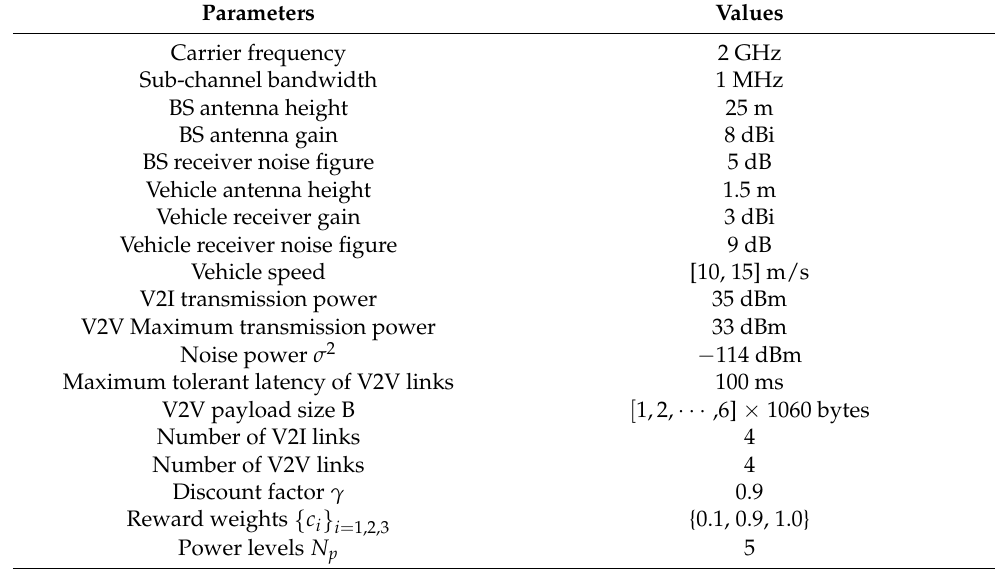
Table 2. The main simulation